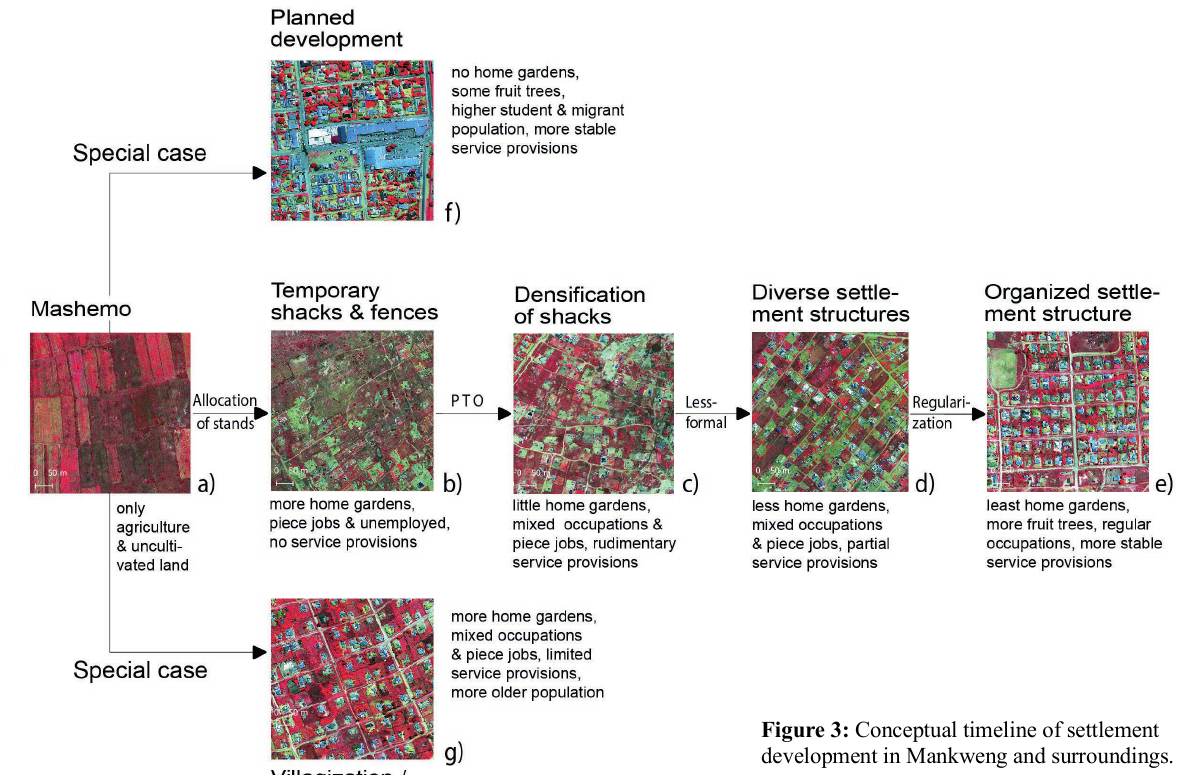
Figure 3: Conceptual timeline of settlement development in Mankweng and